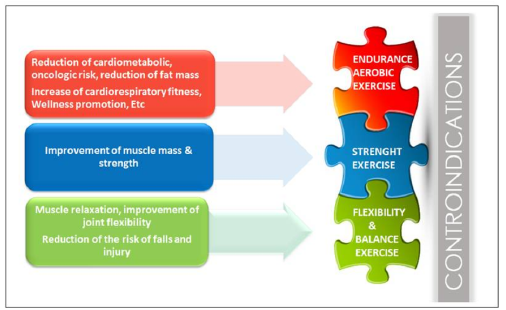
Figure 2. Exercise modalities needed to reach the main clinical